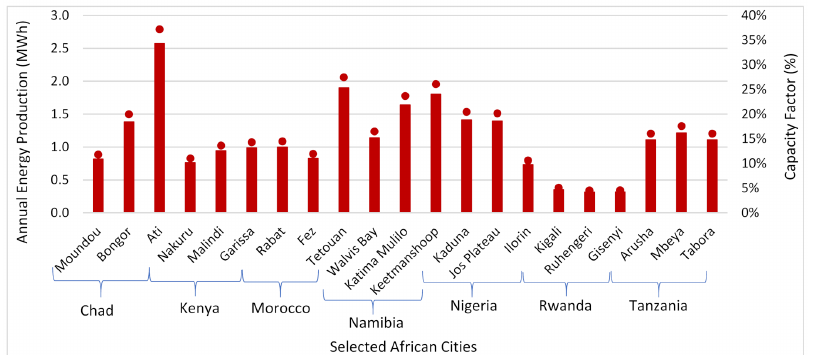
Figure 6. Annual energy production and capacity factor for the FWT design for the selected African cities (Column = Annual Energy Production; Circle = Capacity